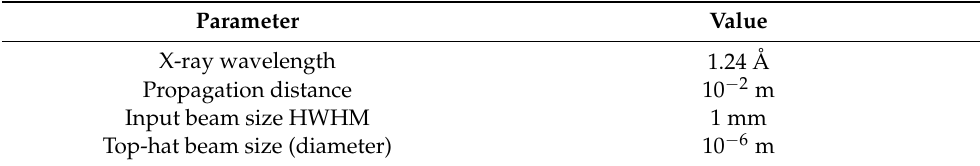
Table 1. Summary of parameters used for simulation .